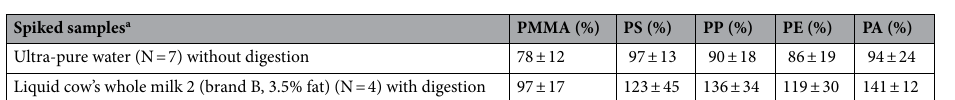
Table 1. Recovery rates of 5 MP standards in ultra-pure water and liquid cow milk (brand B, whole milk 2, 3.5% fat). a After blank subtraction of PP, PE and PS contaminations. N represents the number of replicates.